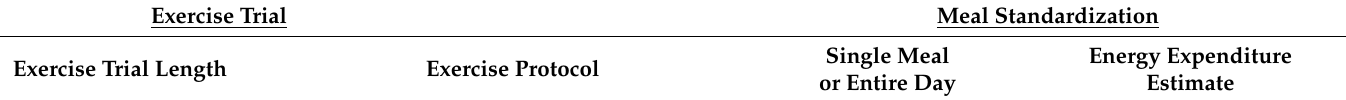
Table 3. Descriptive characteristics of studies that included meal standardization or resistance